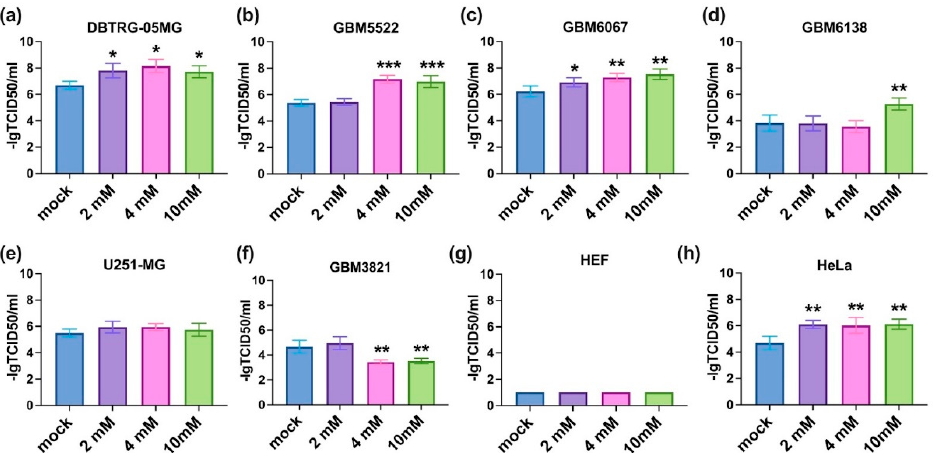
Figure 3. Oncolytic activity of CVB5 towards glioblastoma cells in the presence of 2DG increased in DBTRG-05MG ( a ), GBM5522 ( b ), GBM6067 ( c ), GBM6138 ( d ) and HeLa ( h ), decreased in GBM3821 ( f ) cell line, and did not change in U251-MG ( e ) and HEF ( g ) cell line. Cells were seeded 24 h before treatment with 2, 4, and 10 mM 2DG and simultaneous infection with CVB5 at MOIs of 0.001–1000. Viability was determined using CellTracker method 48 h later, * p ≤ 0.05, ** p ≤ 0.01, *** p ≤ 0.001.